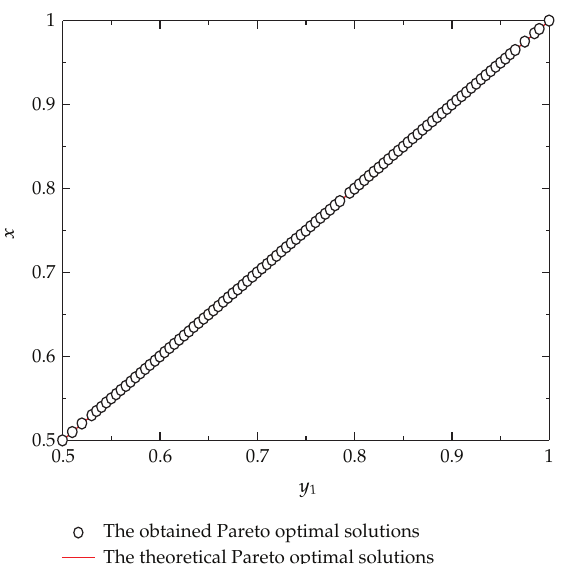
Figure 4: The obtained solutions of Example